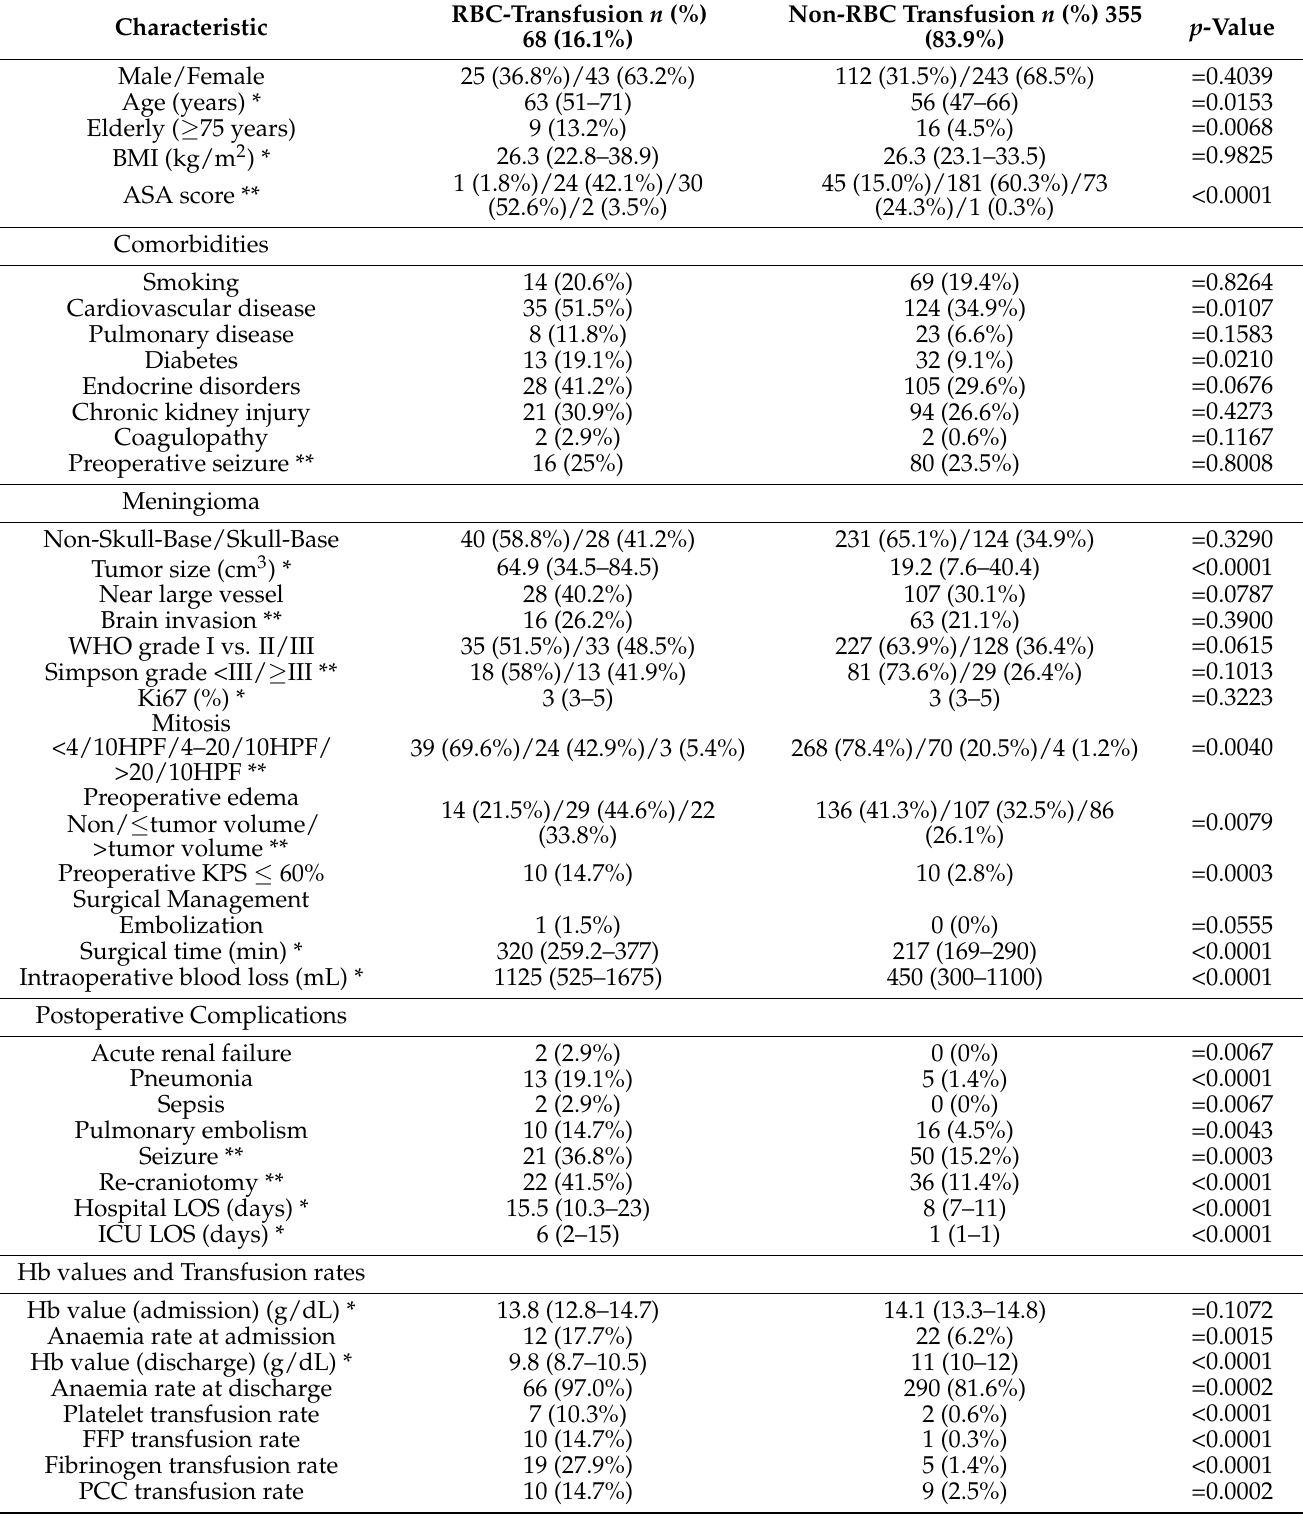
Table 1. Demographic and meningioma data, postoperative complications, and transfusion rates between the RBC transfusion and non-RBC transfusion